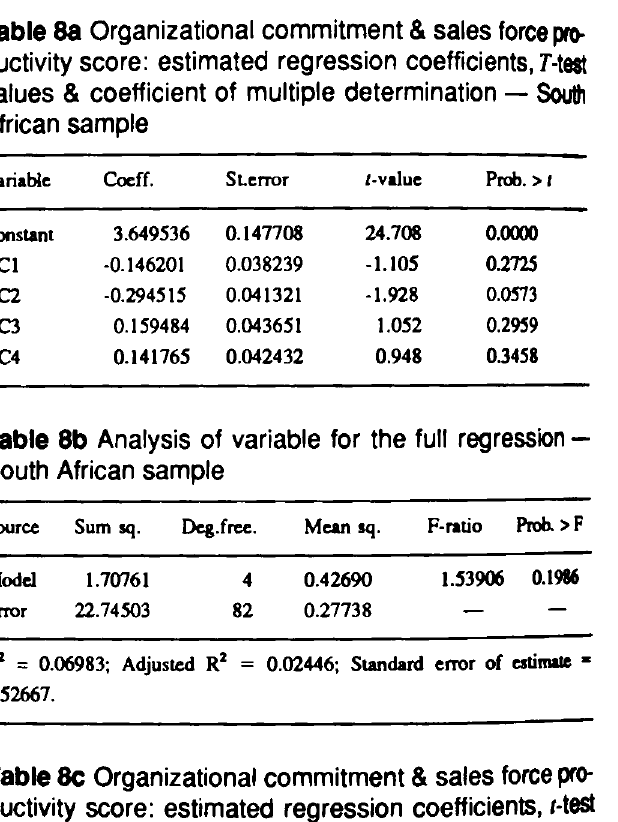
Table 7c Ethical values & sales force productivity score: estimated regression coefficients, t-test values & Table 8c Organizational commitment & sales force pro- - coefficient of multiple determination